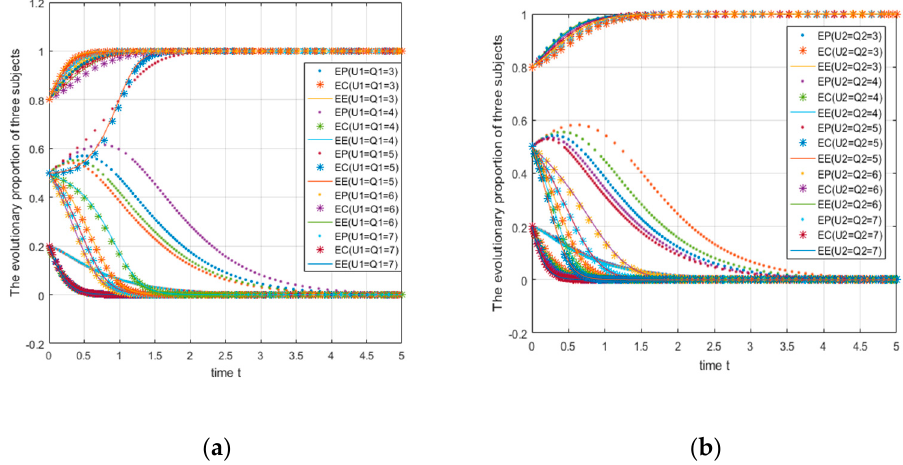
Figure 8. The evolutionary image of consumers and e-commerce companies with consistent revenue parameters while changing in the same direction.